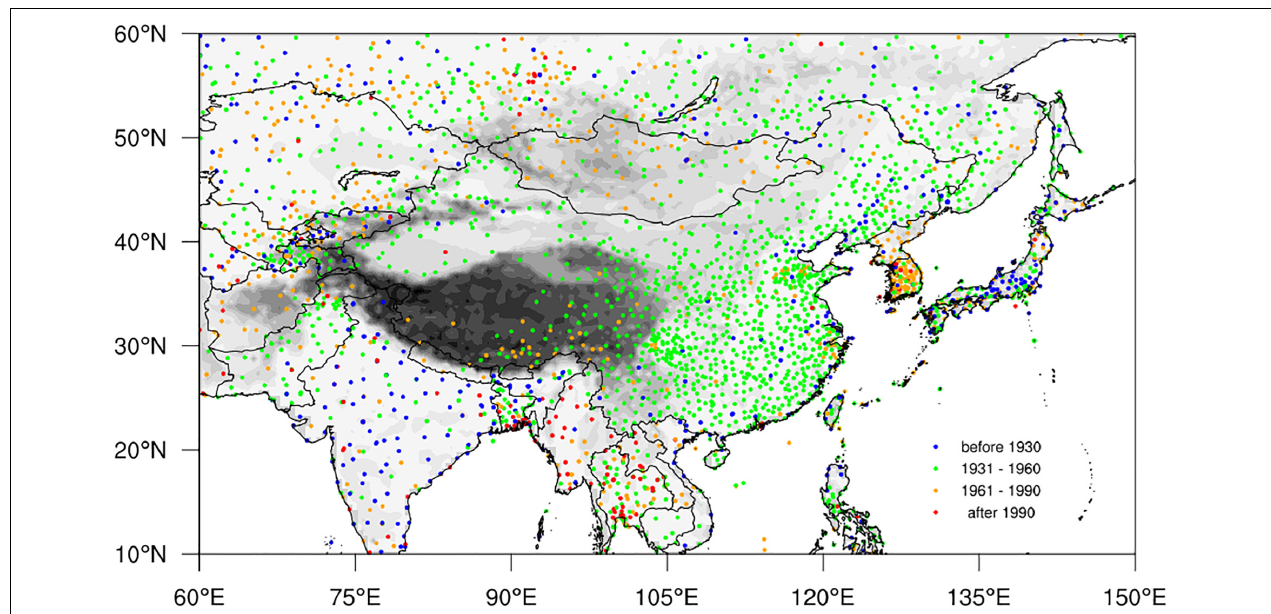
FIGURE 1 | Spatial distribution of the observational stations in the C-LSAT2.0 dataset in the Pan-East Asia regions. The different colored dots represent stations with different starting years (SY) of observations.